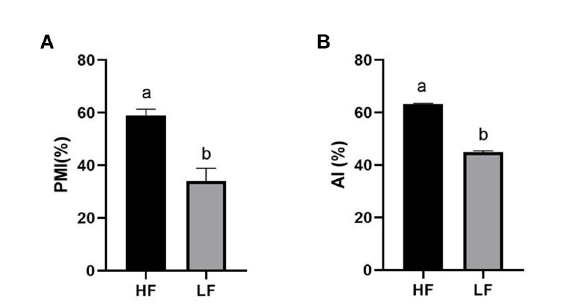
FIGURE2 Differences of sperm parameters. Percent differences in the levels of (A) PMI, plasma membrane integrity, (B) AI, acrosome integrity. The data are presented as mean ± SEM. ( P < 0.05, calculated using Student’s t -test).